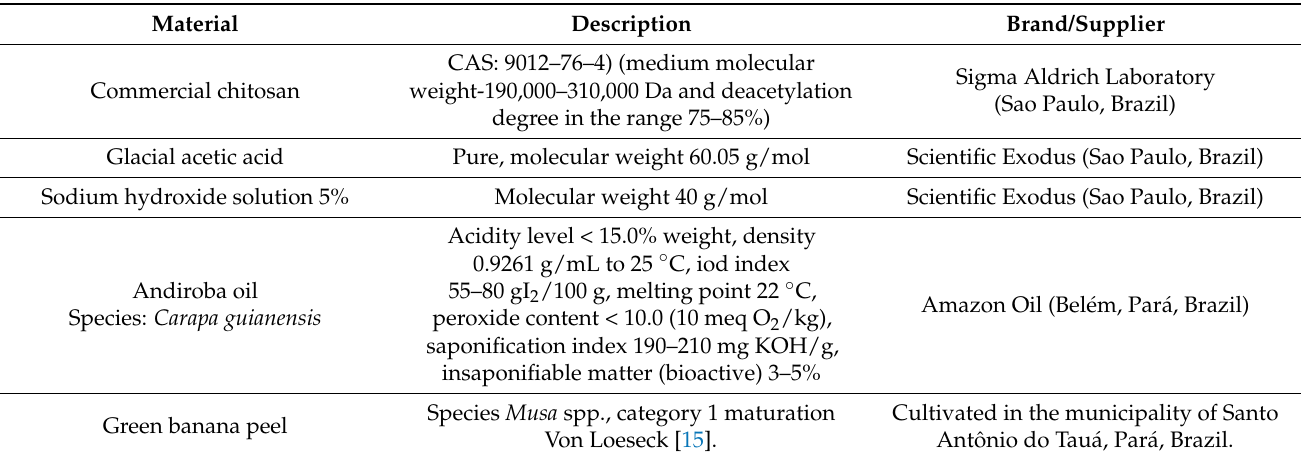
Table 1. Description of the materials used in the synthesis of